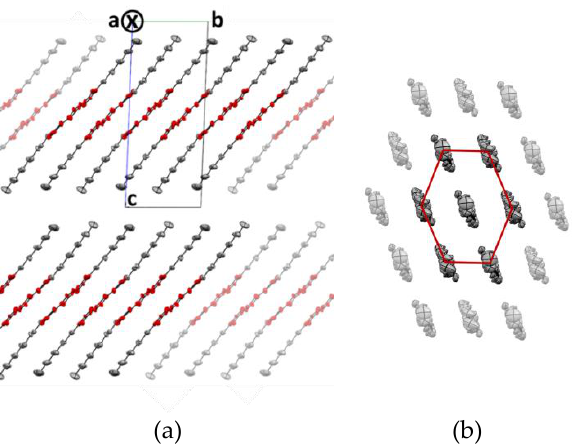
Figure 7. Crystal structure of Th-Thd-Th(10) showing lamellar order ( a ) and pseudo-hexagonal intra-layer packing ( b ). Legend: Alkyl chains in grey, aromatic core in red, hydrogens omitted for clarity.